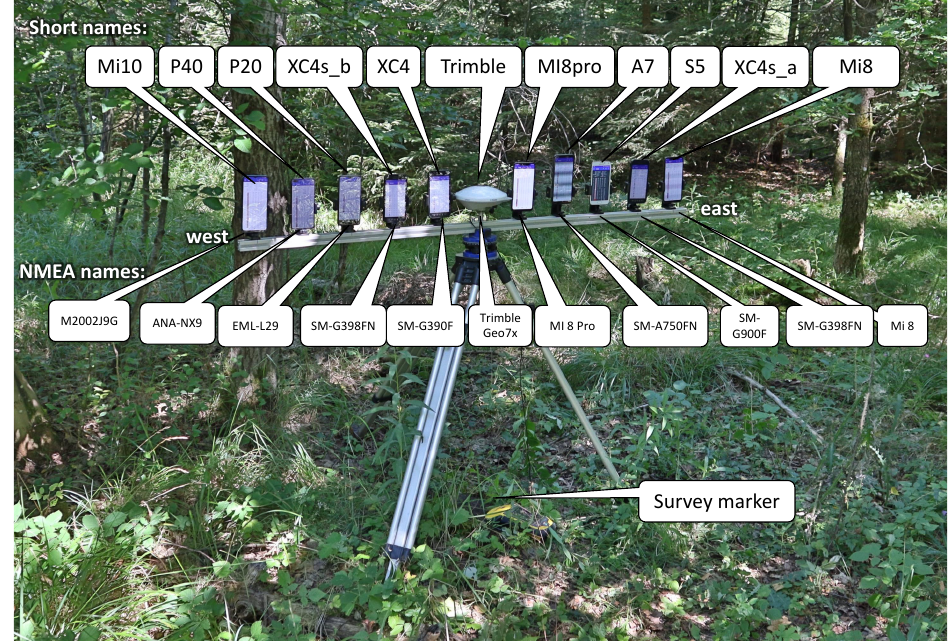
Figure 3. Arrangement of the smartphones and the Trimple GNSS receiver above the survey marker under a forest canopy. The smartphones were placed with a known defined offset in an east– west